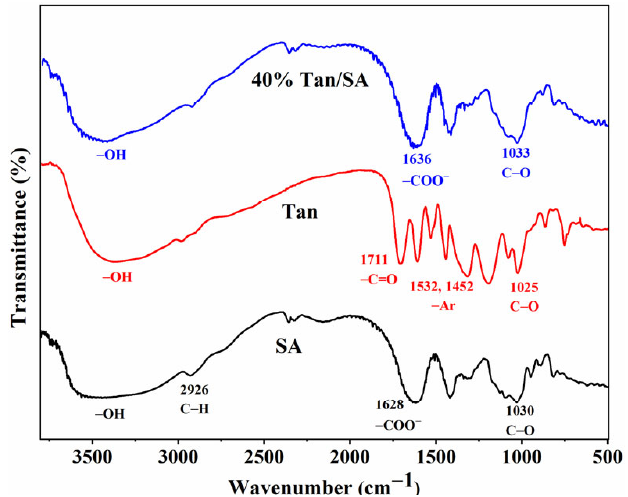
Figure 3. FTIR spectra of SA, Tan, 40% Tan/SA beads.